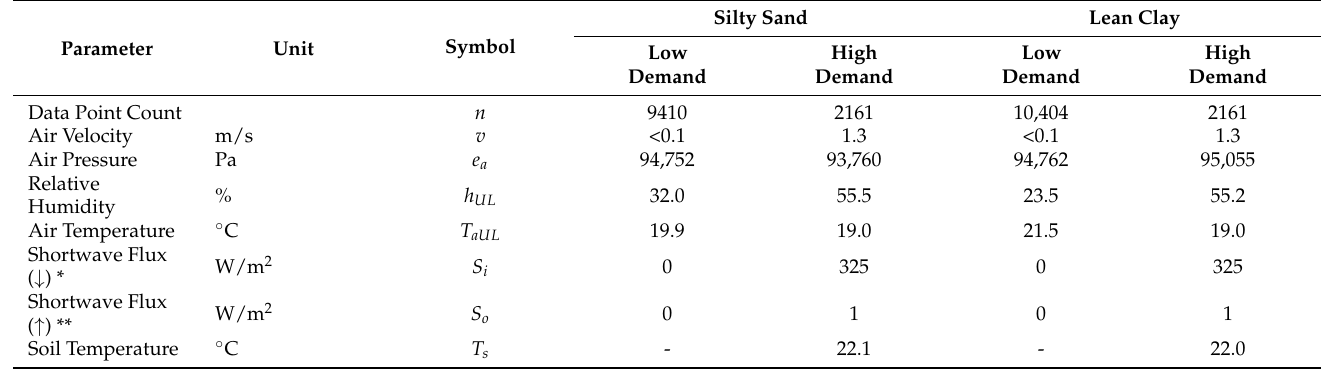
Table 2. Summary of measured atmospheric and surface